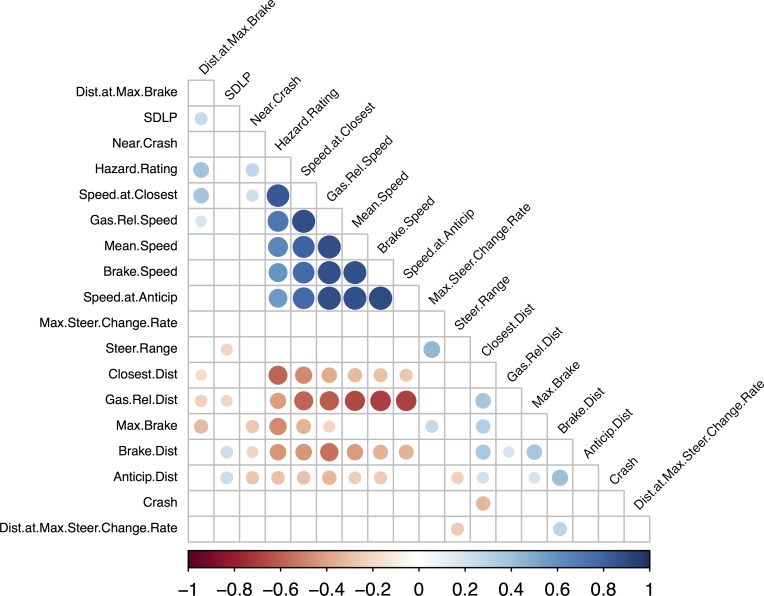
Graphical representation of the correlational analysis on the aggregated dataset performed using hierarchical clustering analysis in the R statistical environment (R Development Core Team, 2008).The size and color of each circle represents the magnitude and the direction of the correlation, respectively. Note that only the significant correlations (p< .05) appear on this graphical representation. As a striking result, the data can be clearly shown to be distributed into two clusters: one with positive correlations centered on Mean Speed and the other with negative correlations between speed measures and distance measures.